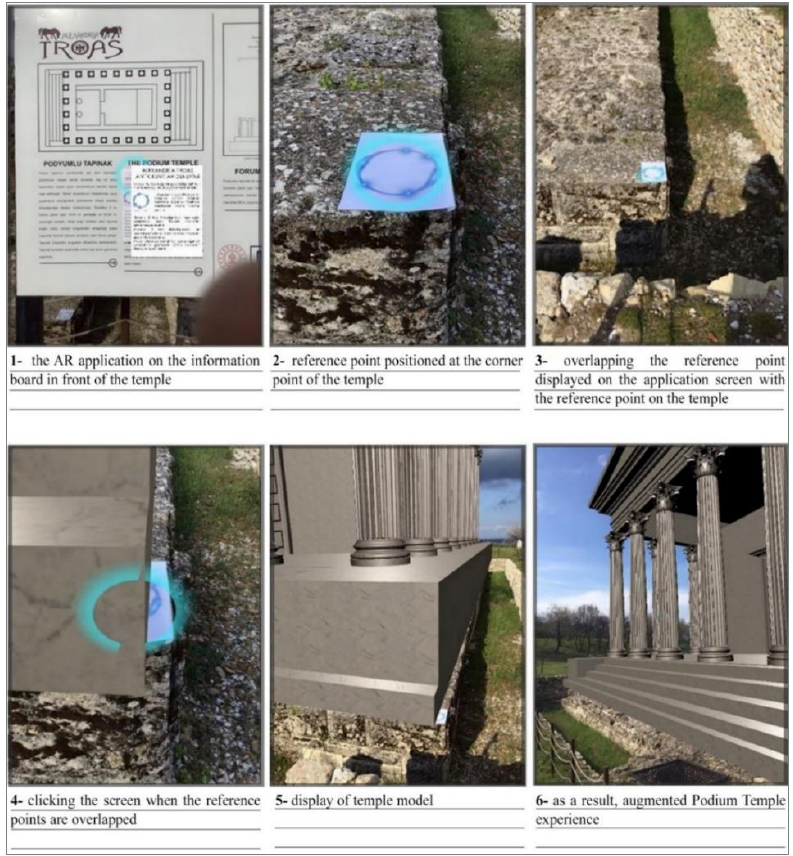
Figure 13 Manual Placement of Virtual